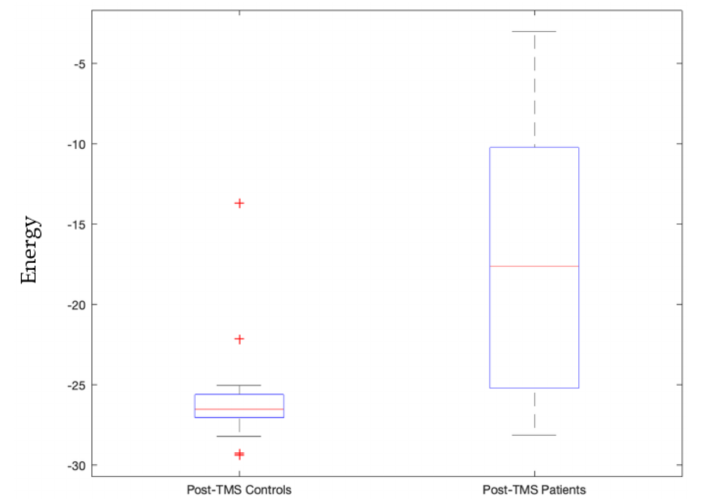
Figure 5. Energy values of controls significantly differed from patients during post-TMS subthreshold pulse stimulation condition at the vermis with a p -value = 0.000048 for the inactive energy state of the frontoparietal network. TMS subthreshold pulse was administered at the